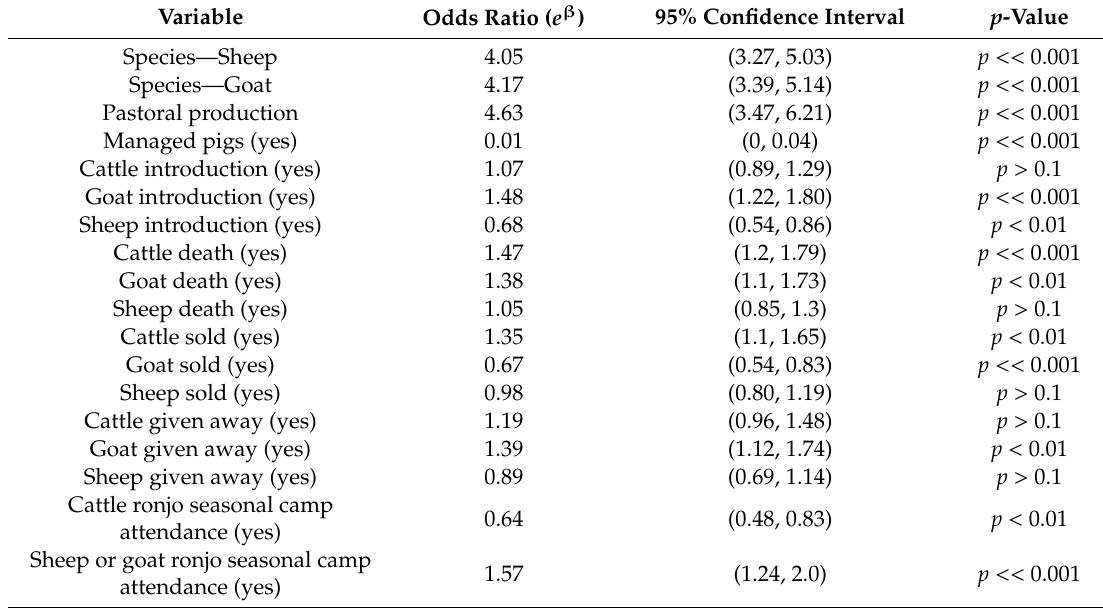
Figure 5. Boxplots of the distribution of the household herd force of infection (FOI, square root transformed, unit = year − 1 ) by varying species composition during grazing practices. There was a significant increase (Kruskal–Wallis test, p -value < 0.005) in the household herd FOI for households that reported grazing cattle (C) separately from combined sheep and goats (S + G) as opposed to all three species together (C + S + G). ** Comparison significant ( p < 0.005) by Kruskal–Wallis test. Table 2. Multivariable logistic regression results assessing the relationship between specific production system variables and PPRV